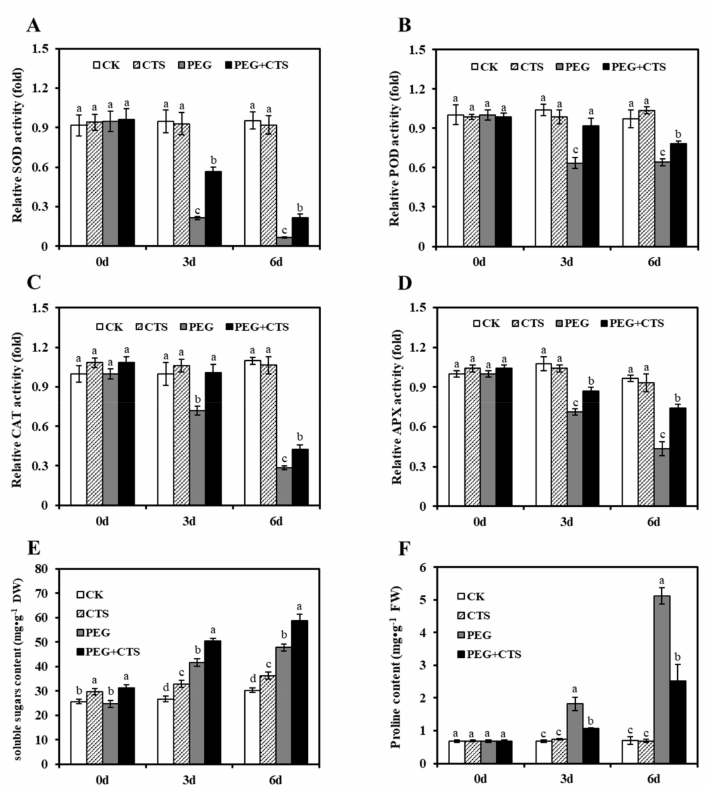
Figure 3. E ff ect of chitoscan (CTS) pre-treatment on changes of antioxidant enzymes superoxide dismutases (SOD) ( A ), POD ( B ), CAT ( C ), APX ( D ), soluble sugars ( E ), and proline ( F ) content in annual ryegrass under osmotic stress condition. Vertical bars represent mean values ± SD for each mean. Di ff erent letter indicates significant di ff erences at given day ( P ≤